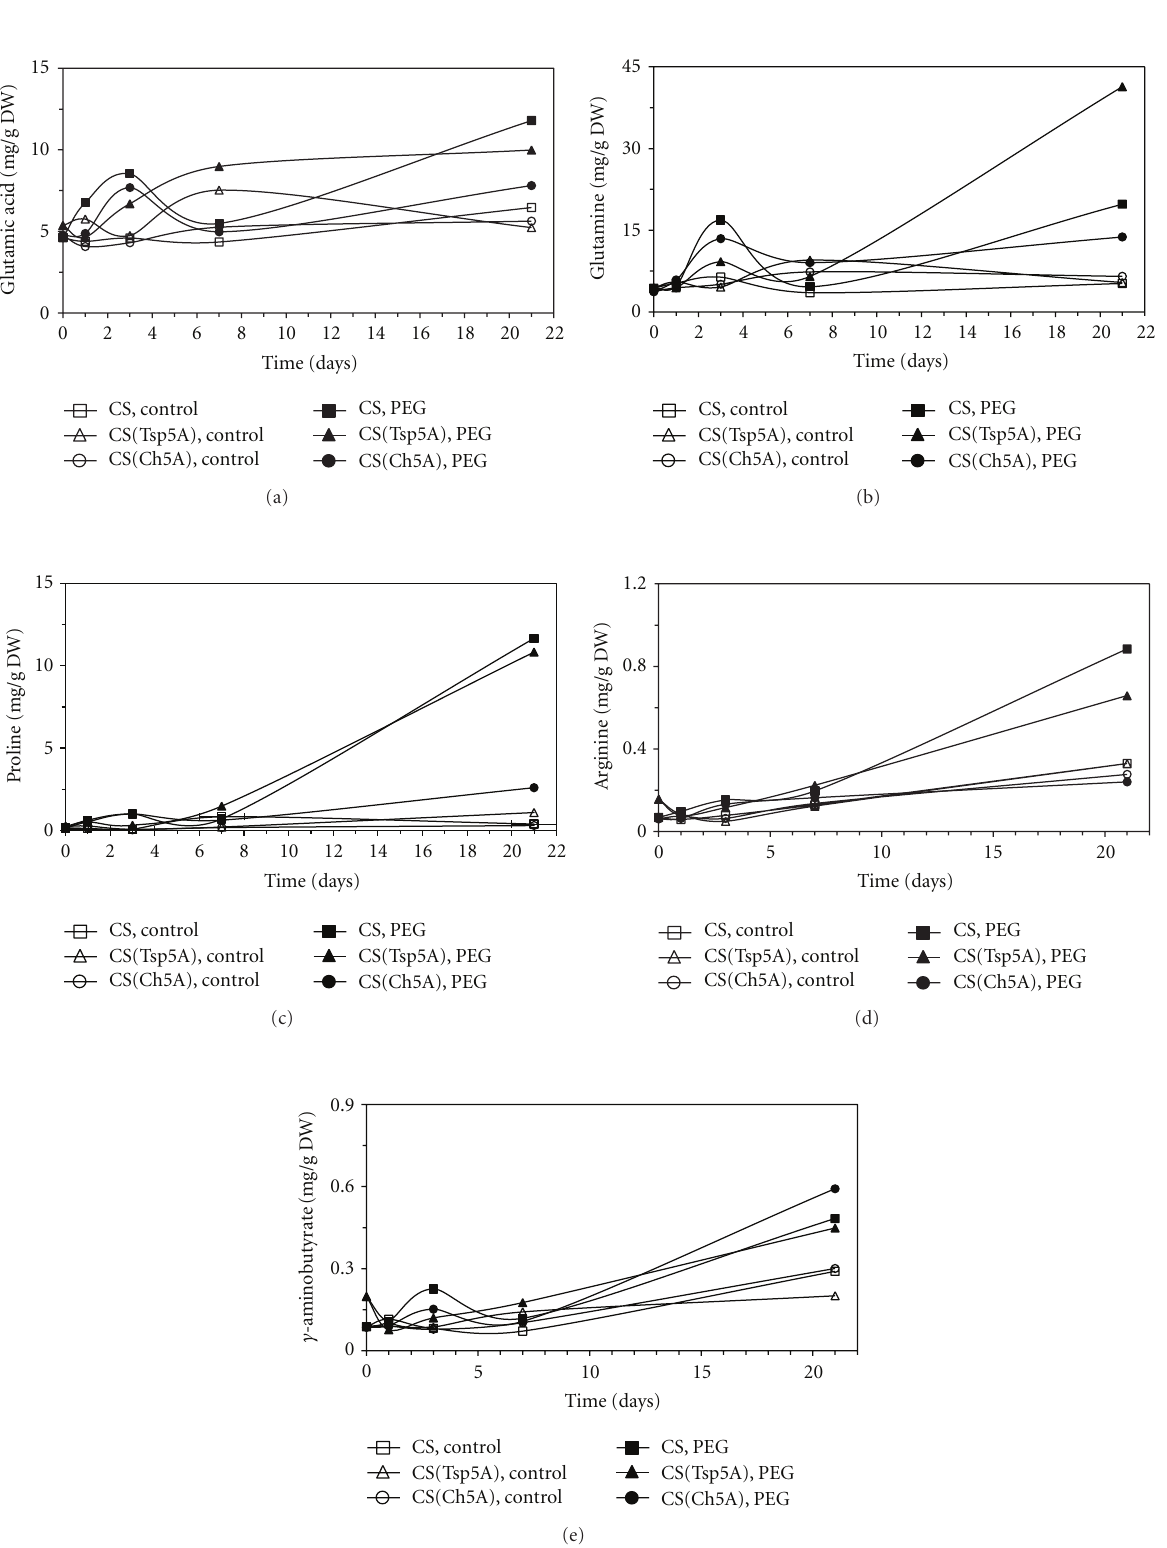
Figure 4: E ff ect of osmotic stress on the concentration of amino acids belonging to the glutamate family. The time course of changes was compared under control and stress (15% PEG) conditions in the freezing-sensitive CS and CS(Tsp5A) and the freezing-tolerant CS(Ch5A) wheat genotypes. The standard deviations of the data were below 10% in each case (not shown on the graphs because of the better transparency). (a): Glu (SD: 1.66), (b): Gln (SD: 5.10), (c): Pro (SD: 1.67), (d): Arg (SD: 0.070), and (e): γ -aminobutyrate (SD: